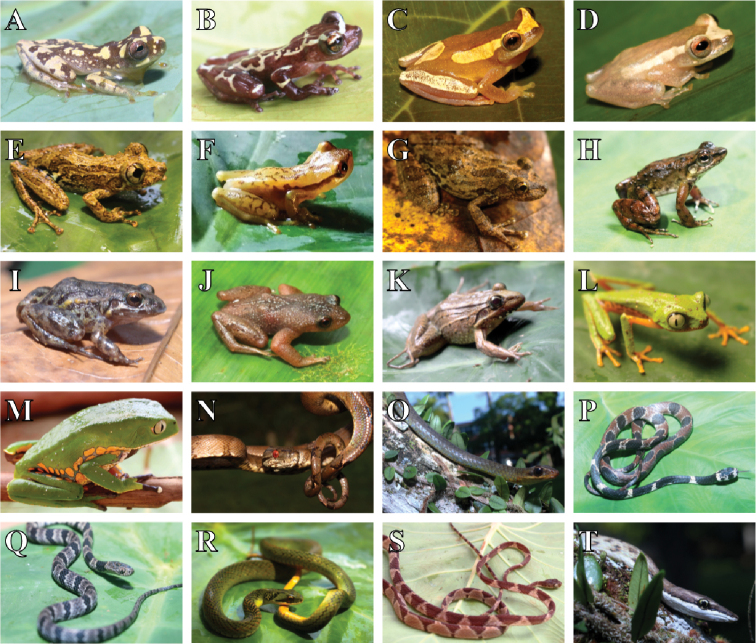
Amphibians and reptiles recorded in the Parque Nacional da Serra das Lontras. ADendropsophus
branneriBDendropsophus
aff.
bromeliaceusCD.
elegansDD.
haddadiEOlolygon
strigilataFPhyllodytes sp. 1 GScinax
cf.
x-signatusHCrossodactylus sp. IAdenomera clade M JCrossodactylodes
septentrionalisKLeptodactylus
cf.
latransLPhasmahyla
spectabilisMPhyllomedusa
burmeisteriNCorallus
hortulanusOChironius
fuscusPDipsas
catesbyiQDipsas
neuwiediRErythrolamprus
reginae, SImantodes
cenchoaTOxybelis
aeneus.